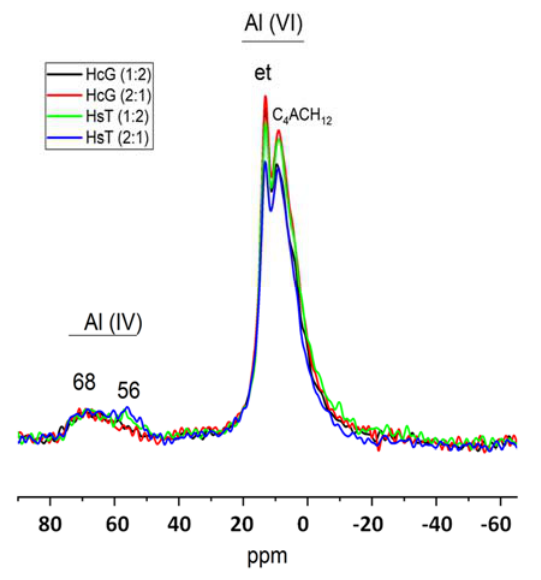
Figure 6. 27 Al NMR spectra for 90-day 7% HsT/glass pastes.